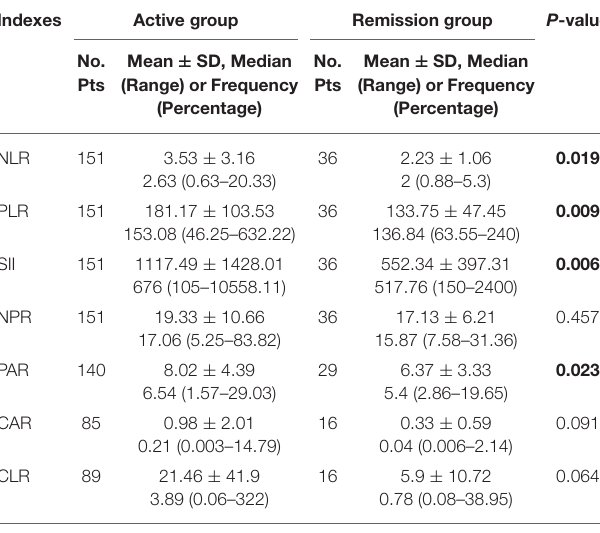
TABLE 2 | Comparison of inflammatory indexes between active and remission UC groups.